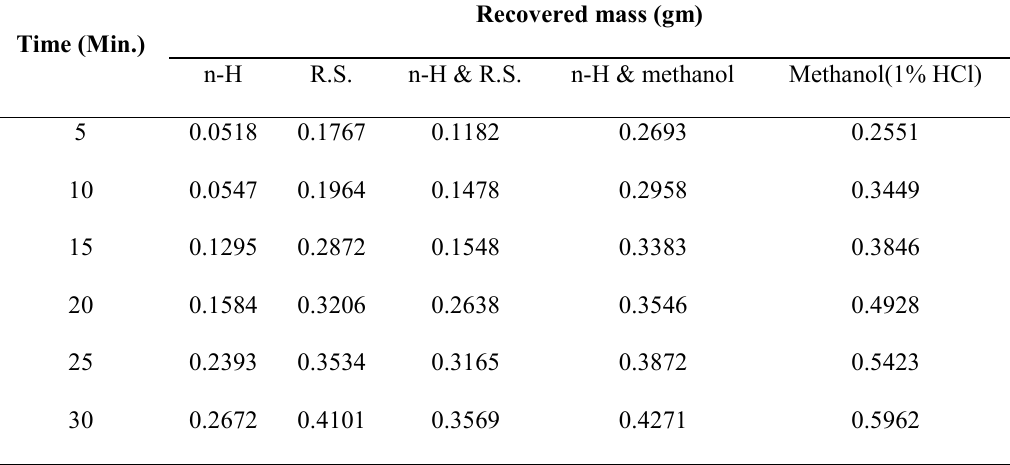
Table 1. Optimization data for maximum Extraction yield in ASE. Time